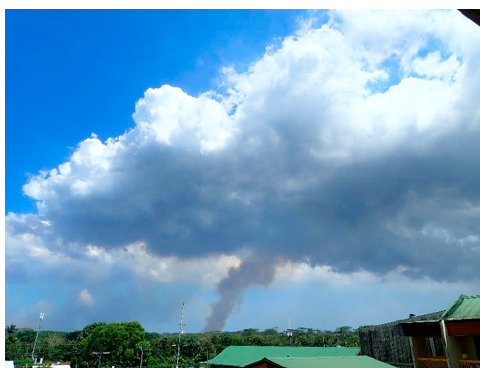
Figure 9. Water vapor and aerosols in the eruption plume from Fissure 8 of the Kilauea volcano created a persistent weather system that sometimes included thunderstorms. This photograph was made from a second-floor overlook at the P ā hoa High and Intermediate School on 31 July 2018.